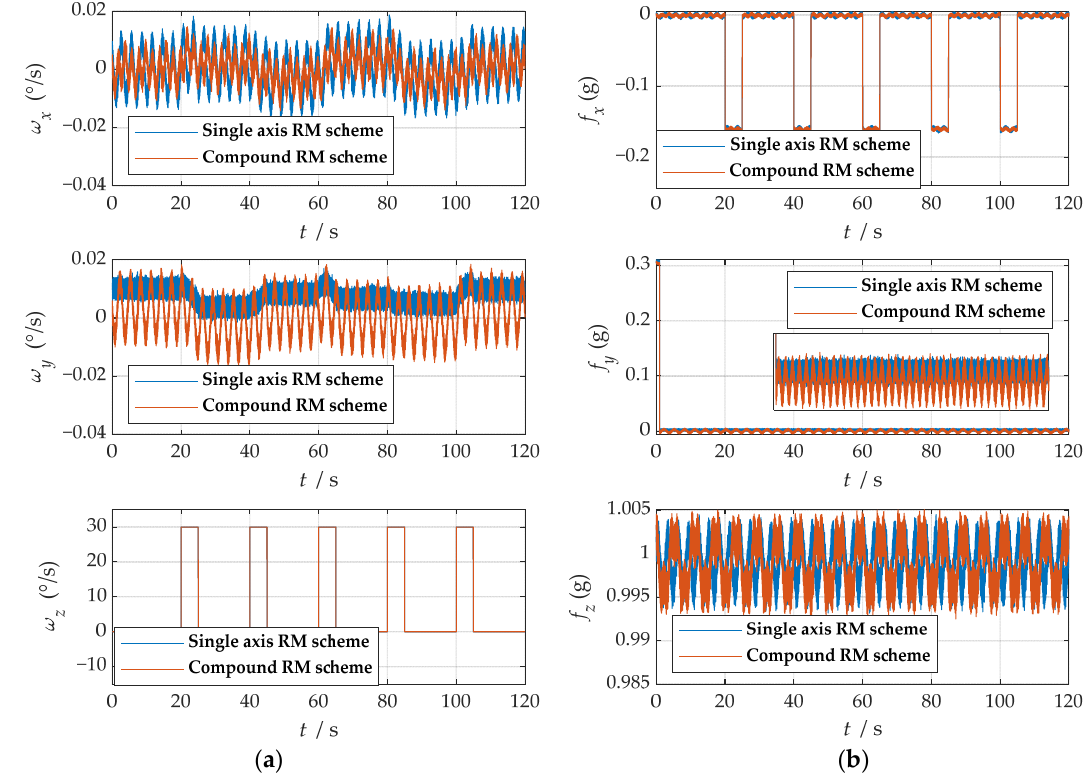
Figure 11. The navigation information of the b-frame obtained after coordinate system transformation: ( a ) angular velocity information; ( b ) specific force information.